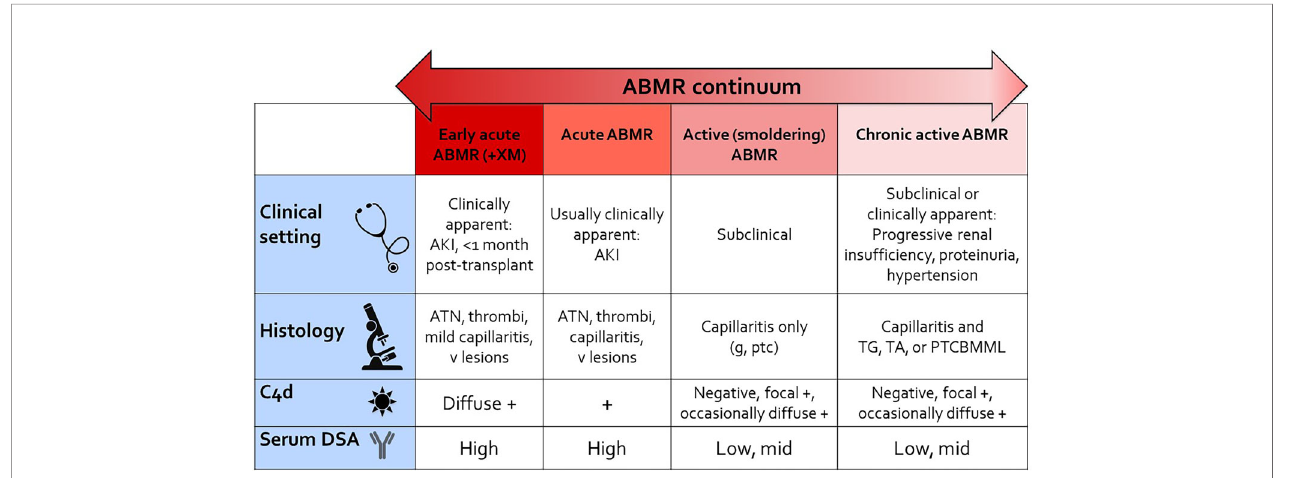
FIGURE 3 | ABMR continuum. This schematic provides a reference for thinking about the continuum of “ pure ABMR ” in kidney transplant recipients with preformed DSA, as detailed in this article. Not included in the fi gure is combined ABMR and T cell mediated rejection in patients with de novo DSA and under- immunosuppression (iatrogenic or due to nonadherence). AKI, acute kidney injury; ATN, acute necrosis/injury; g, glomerulitis; ptc, peritubular capillaritis; v lesions, Banff vascular lesions (endothelialitis, fi brinoid necrosis of vessels); TG, transplant glomerulopathy; TA, transplant arteriopathy; PTCBMML, peritubular capillary basement membrane multilayering (by electron microscopy); +XM, positive